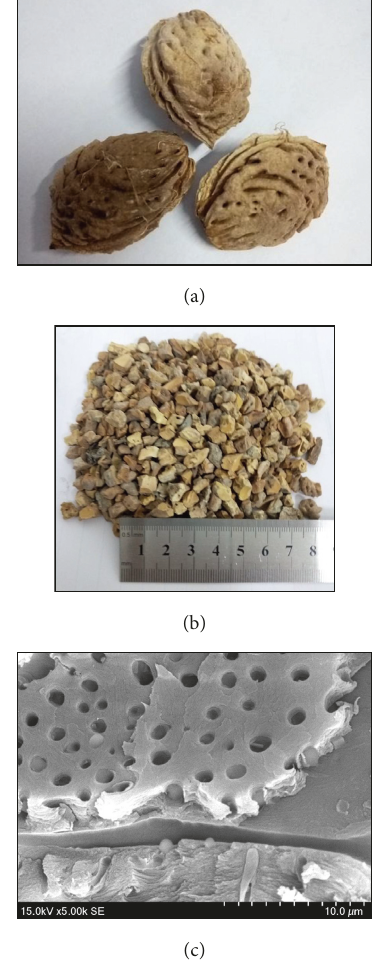
Figure 1: (a) Uncrushed PS, (b) crushed PS, and (c) SEM image of the crushed PS particle at 5000 magnification